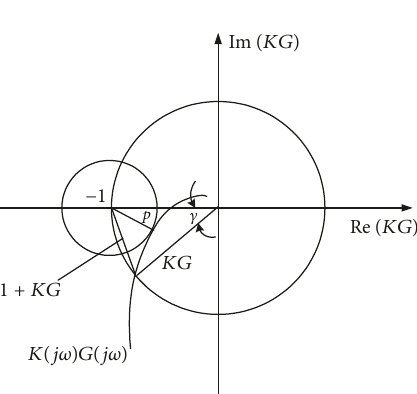
Figure 3: The relationship between phase margin γ and p